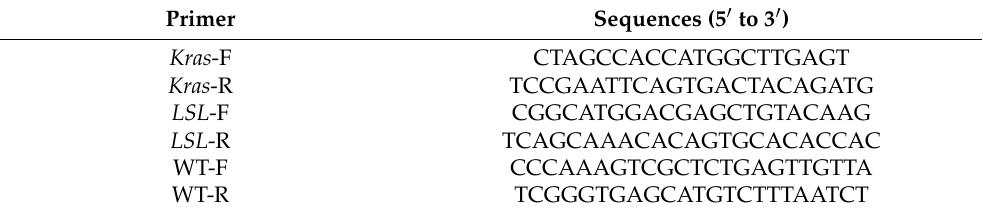
Table 3. The sequence of primers for genotyping. Primer Sequences (5 (cid:48) to 3 (cid:48) ) Kras -F CTAGCCACCATGGCTTGAGT Kras -R LSL